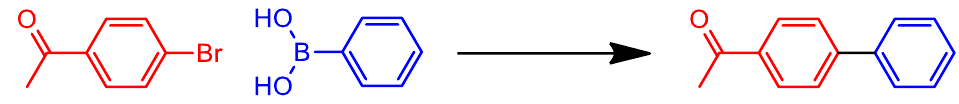
Figure S2: 1 H NMR spectra of 4-bromoacetophenone (A) and S-M coupling product with phenyl boronic acid